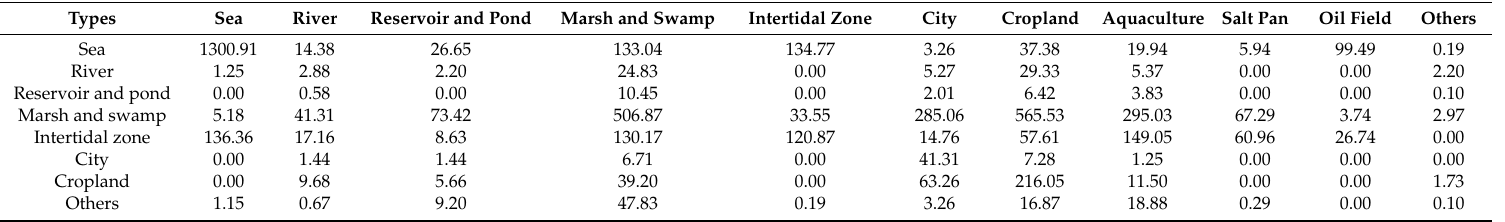
Table 6. The land cover transition matrix for the Yellow River Delta 1973–2013 (units: km 2